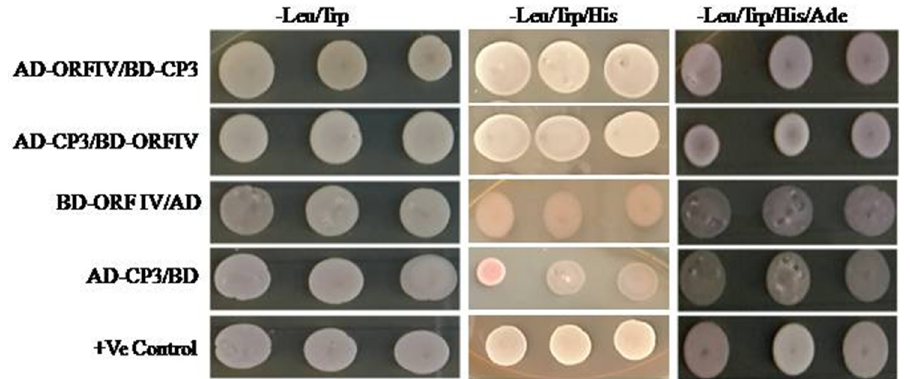
Figure 4. Yeast two-hybrid assay for direct interaction study. Yeast colonies of pGAD-CP3 and Figure 4. Yeast two ‐ hybrid assay for direct interaction study. Yeast colonies of pGAD ‐ CP3 and pGBD-ORF-IV were co-transformed and selected on (i) two drop out plate (Leu − Trp − ), (ii) triple pGBD ‐ ORF ‐ IV were co ‐ transformed and selected on (i) two drop out plate (Leu ˉ Trp ˉ ), (ii) triple drop out (Leu − Trp − His − ), and (iii) triple drop out (Leu − Trp − His − ) supplemented with 5 µ M drop out (Leu ˉ Trp ˉ His ˉ ), and (iii) triple drop out (Leu ˉ Trp ˉ His ˉ ) supplemented with 5 μ M 3 ‐ AT. 3-AT. Co-infiltration of pGAD-CP3 with pGBD and pGAD with pGBD-ORF-IV was performed as the Co ‐ infiltration of pGAD ‐ CP3 with pGBD and pGAD with pGBD ‐ ORF ‐ IV was performed as the control.